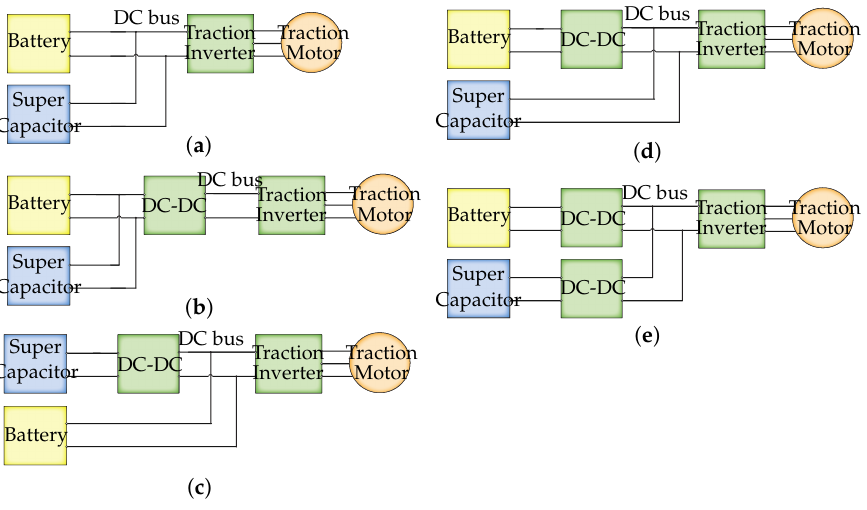
Figure 1. Onboard energy storage system (ESS) configurations: ( a ) Passive battery/SC (supercapacitor). ( b ) Passive cascaded battery/SC. ( c ) Active cascaded SC/battery. ( d ) Active cascaded battery/SC. ( e ) Multiple DC/DC